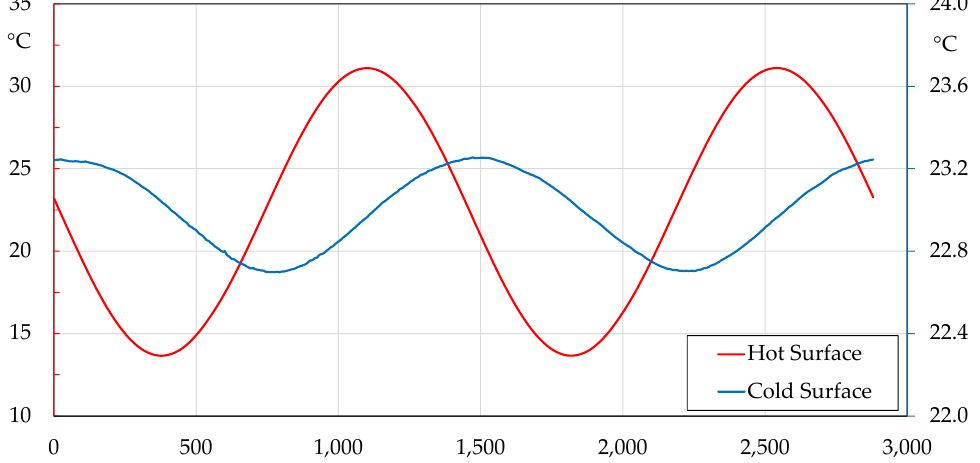
Figure 25. Trends of the sample surface temperatures detected in the climatic chamber by subjecting the external side to a sinusoidal forcing with an average value of 22.5 °C and amplitude of 12.5 °C.